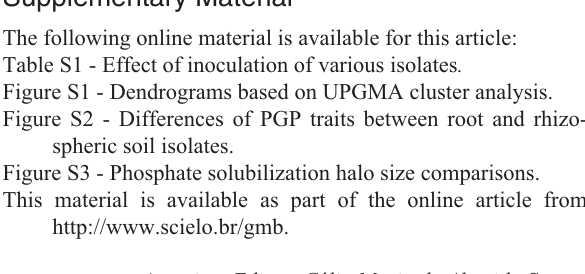
Table S1 - Effect of inoculation of various isolates . Figure S1 - Dendrograms based on UPGMA cluster analysis. Figure S2 - Differences of PGP traits between root and rhizo- spheric soil isolates. Figure S3 - Phosphate solubilization halo size